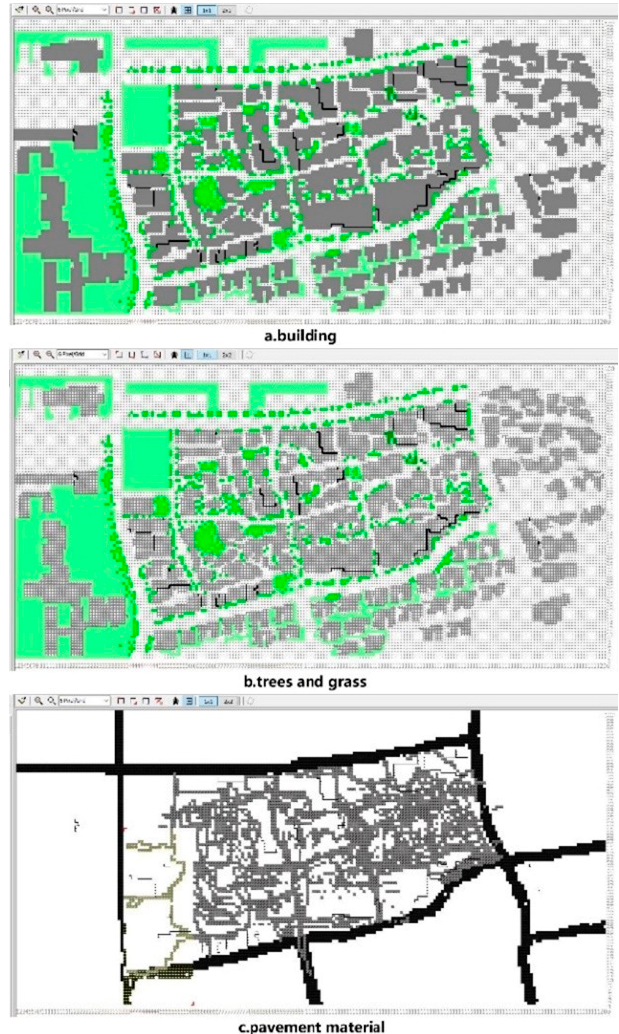
Figure 12. Various types of different coverage ratios of the base case.